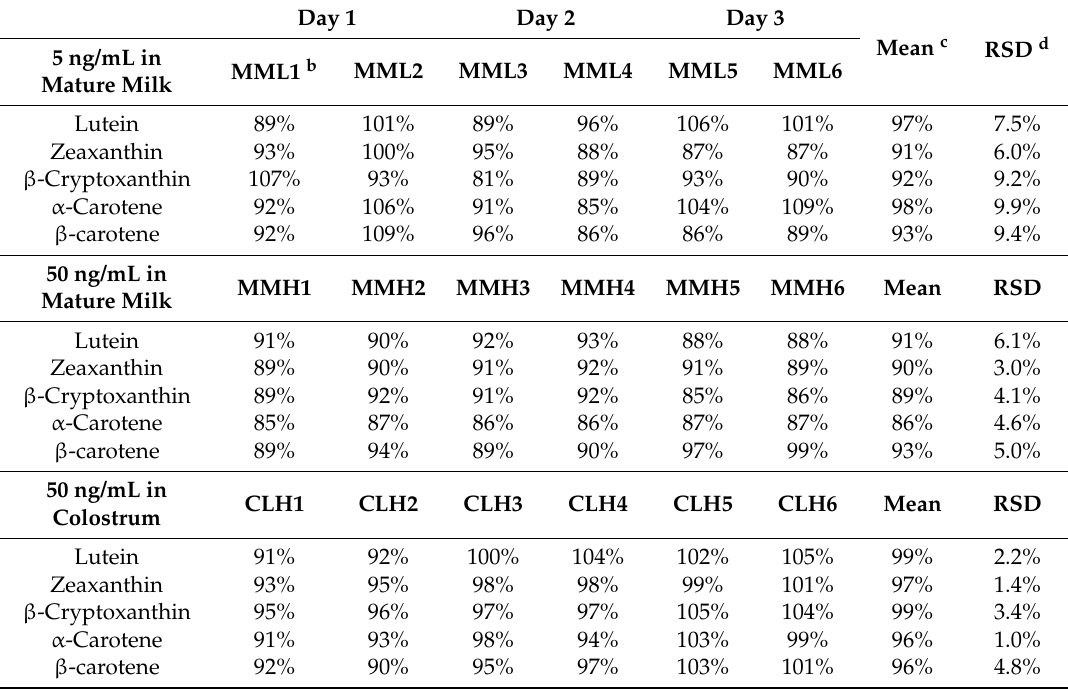
Table 2. Mature milk (MM) and colostrum (CL) over-spike recoveries a